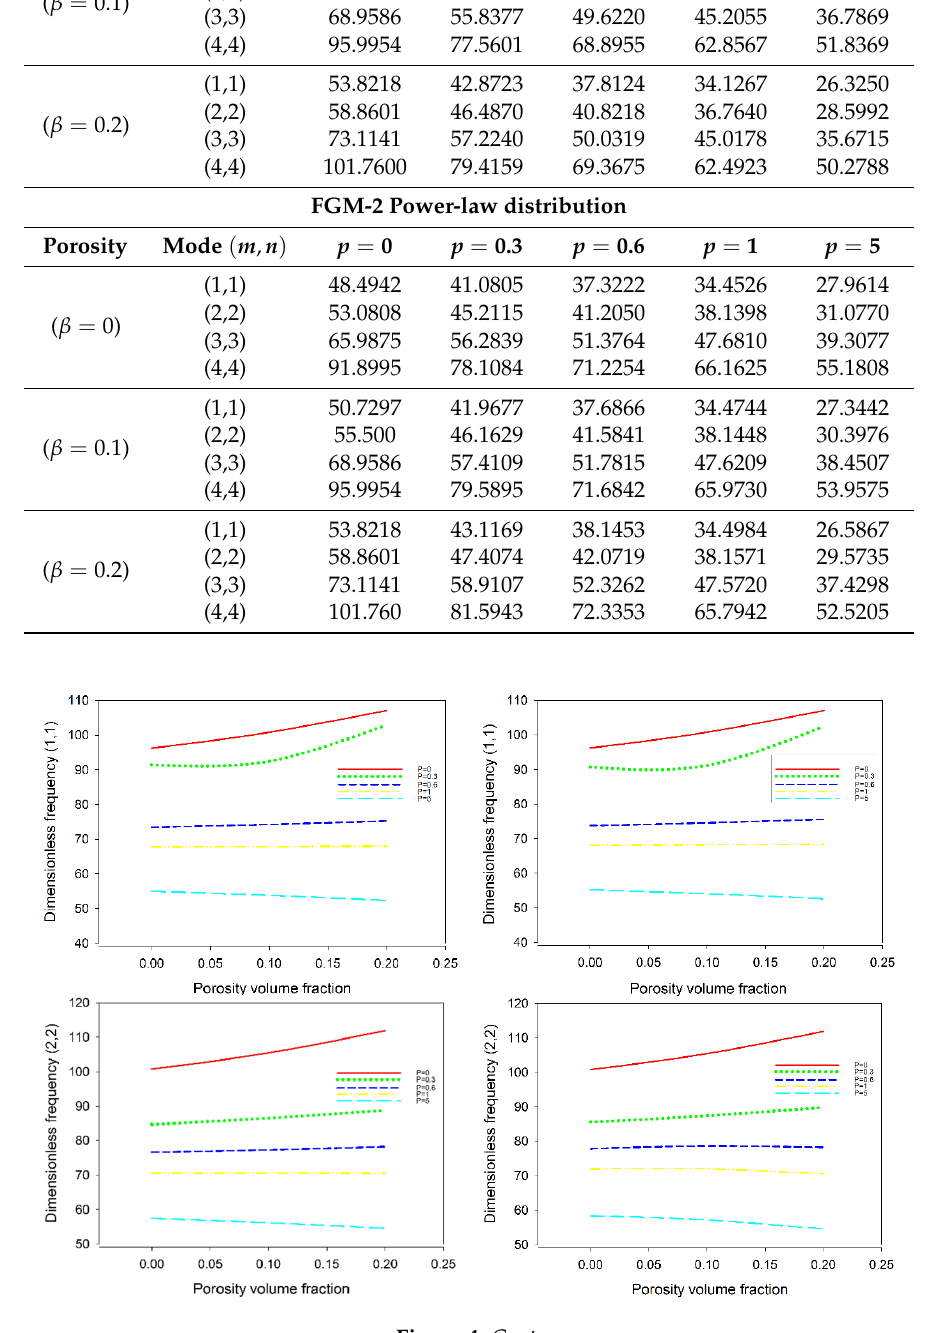
( b ) FGM ‐ type 2 Figure 4. Dimensionless frequency of FG porous spherical shell against different power ‐ law indices and porosity volume fractions distributions: ( a ) FGM ‐ type 1; ( b ) FGM ‐ type 2.